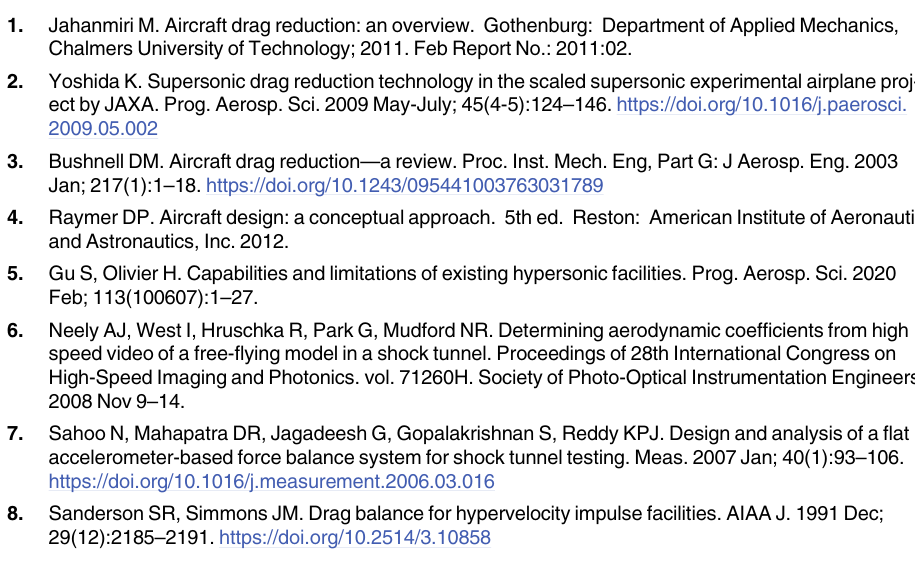
S1 Fig. Fast response force measurement techniques for a short duration. (TIF) S2 Fig. Photographs of test model. (a) FFT, (b) MST, (c) SWT. (TIF) S3 Fig. Mesh grid for numerical prediction of drag force. (a) FFT, (b) MST, (c) SWT. (TIF) S4 Fig. Comparison between the calculation result and schlieren image for the MST. (TIF) S1 Table. Test model size and flow condition obtained from the available literature.